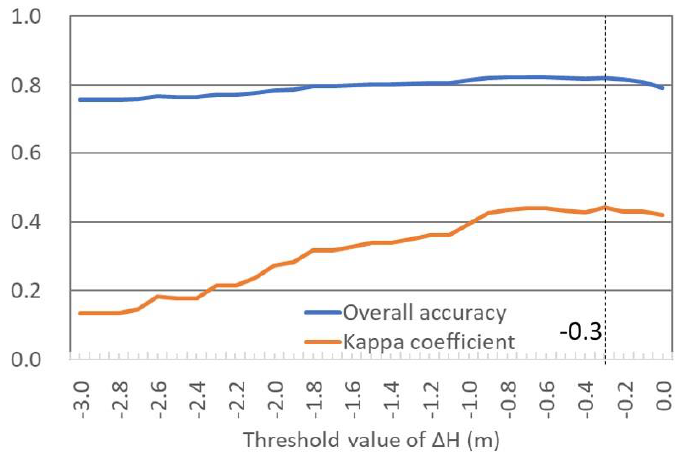
Figure 14. The kappa coefficient and overall accuracy using only ∆ H av and by changing its threshold value in 0.1 m